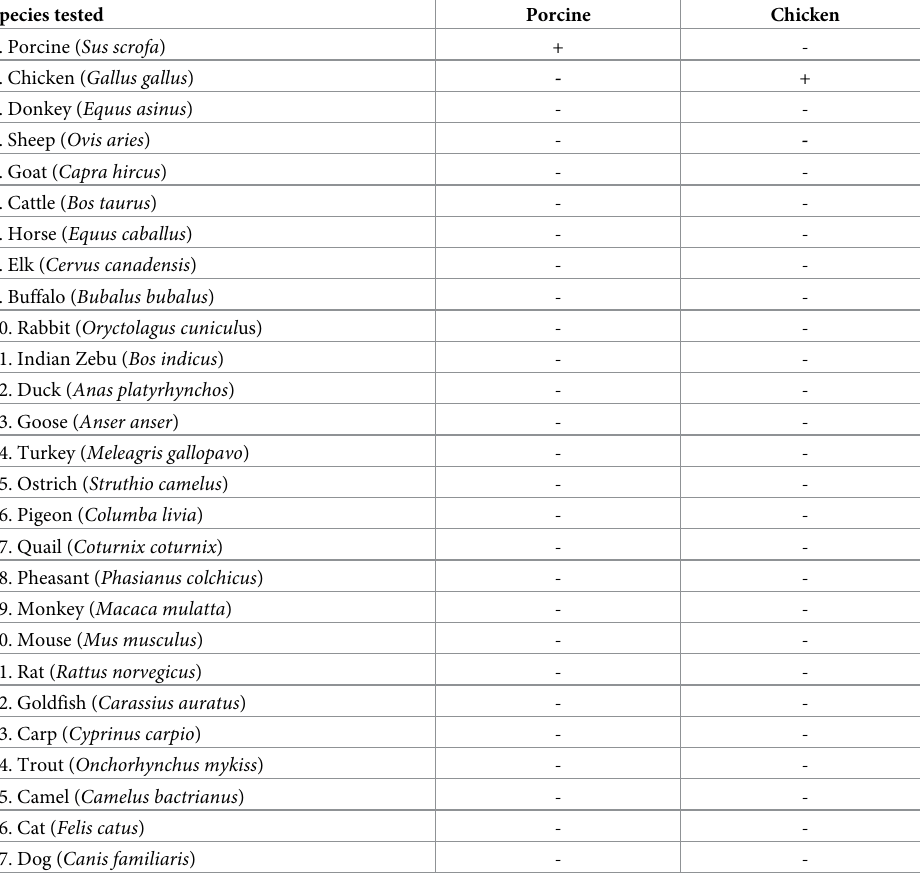
Table 2. Exclusivity of the porcine and chicken material detection method. Species tested Porcine